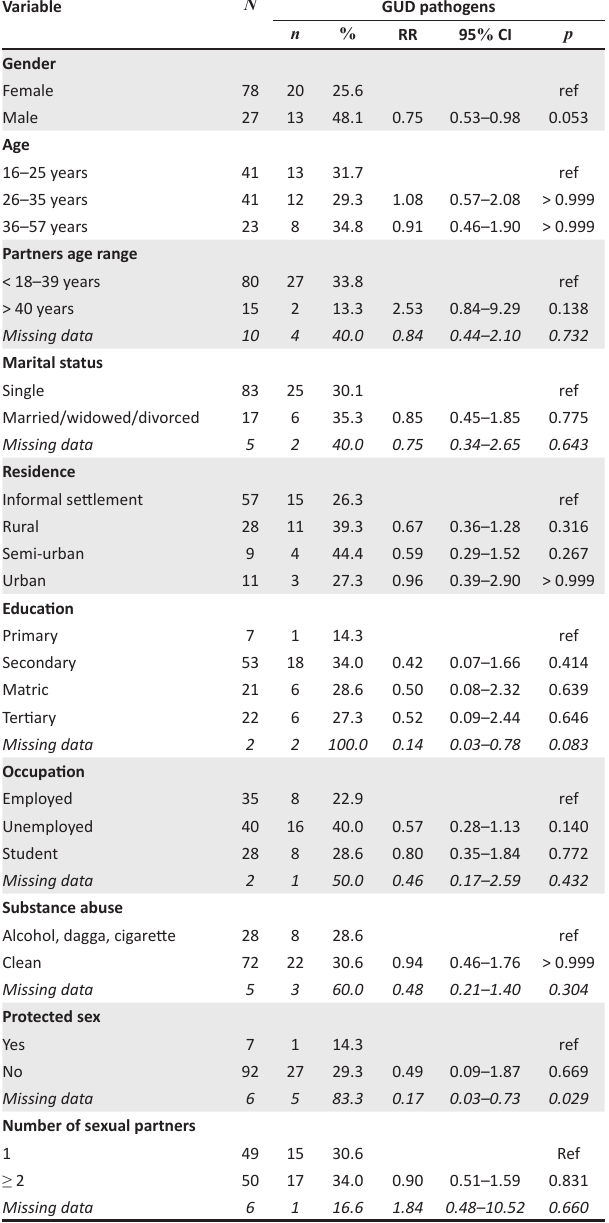
TABLE 4: Demographic factors associated with laboratory detected ulcerating Sexually transmitted infection pathogens. Variable